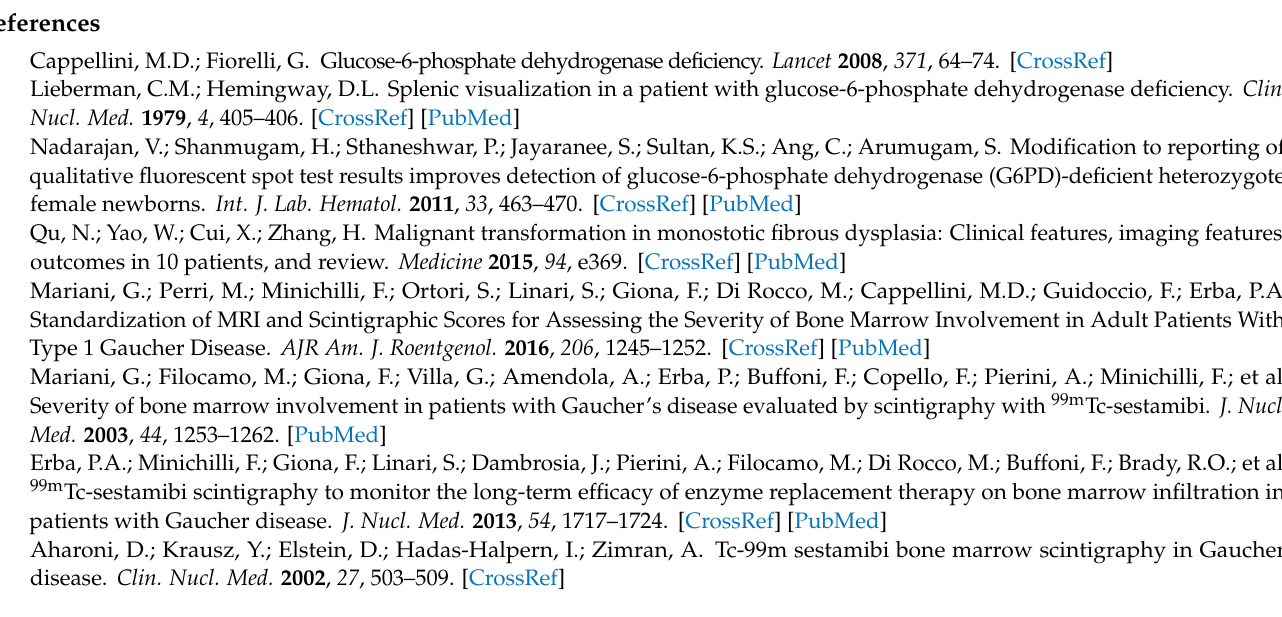
and fusion images of both femora and tibiae. (H–J) CT, PET and fusion images of bilateral humeral bones, Figure S4: Patient 5: (A) 99m Tc-MDP bone scan demonstrated symmetric uptake of radiotracer in the distal femora, tibial metaphyses. (B,C) Coronal and sagittal CT showed osteosclerosis and narrowed marrow cavity in the distal femur, Figure S5: Patient 7: Anteroposterior position (A) and lateral position (B) plain film of the skull. Femora and tibiae of the patient were affected. Diaphyseal osteosclerosis of the distal femur (C), proximal tibia (D), ulna and radius (E) as well as narrowing of the correponding marrow cavities were observed on X-ray plain film, Figure S6: Patient 7: MRI imaging of the lower extremities indicated that bilateral patchy diseases appeared as low SI on T1 WI (A) and heterogeneous high SI on T2 WI (B). The MRI documented a homogeneous intense enhancement of the patchy diseases after gadolinium administration (C), Figure S7: Patient 7: (A) 18 F-FDG-PET/CT demonstrated high glucose avidity of the metaphyses of lower extremities with a SUVmax of 2.4. (B–D) Cortical substance of bilateral distal femora thickened and corresponding marrow cavities narrowed accordingly, accompanied by increased uptake of radiotracer. (E–G) similar changes regarding bone formation and glocuse metabolism were observed in both